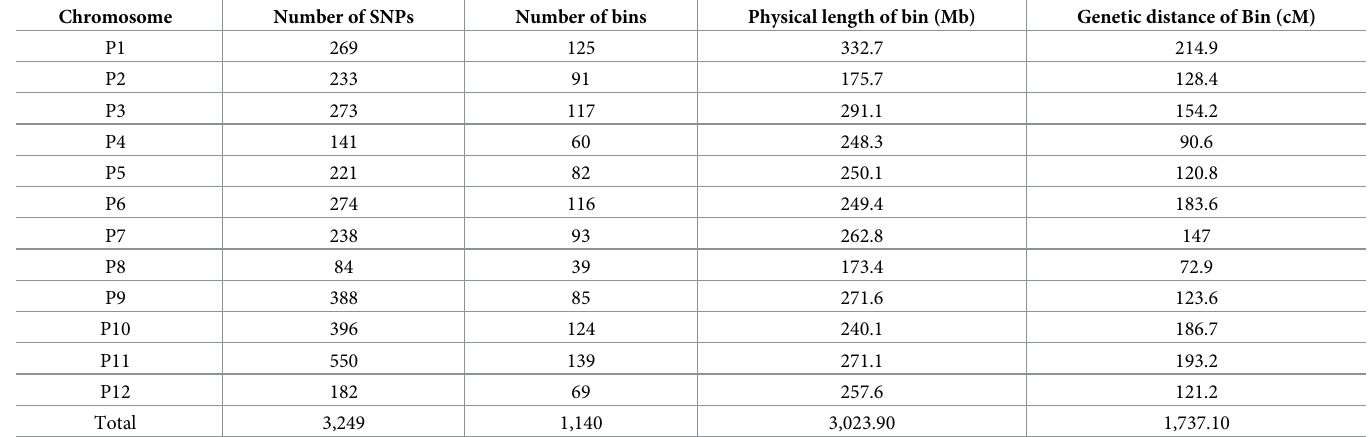
Table 2. Summary of the bins and genetic linkage map for the LP97-F 2 population. Chromosome